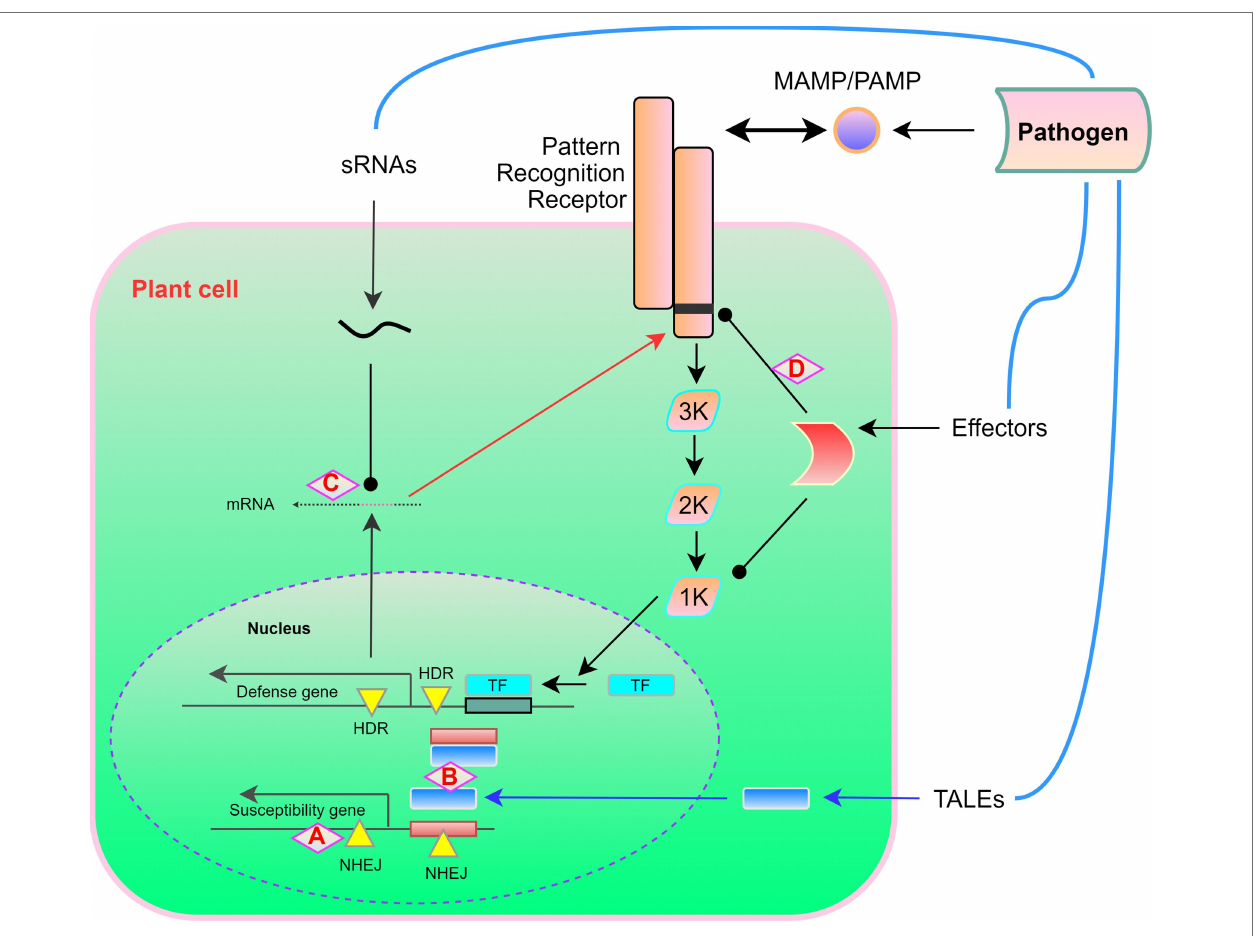
FIGURE 3 | A potential target for applying CRISPR-Cas for engineering of “non-transgenic” disease resistance in plants. In response to pathogen recognition, the plant-induced defense response involves a MAP kinase phosphorylation cascade, which leads to the activation of transcription factors and the expression of defense-related genes. (A) Open reading frame disruption by non-homologous end joining (NHEJ) causes frameshift mutations in susceptibility genes. (B) NHEJ eliminates cis elements to prevent transcription activator-like effector (TALE) activation of susceptibility genes and homology-directed repair (HDR) introduces cis elements, which promotes the TALE-triggered activation of defense genes. (C) Rewriting of transboundary RNAi via HDR-mediated pathogen siRNA targeting. (D) HDR-mediated coding sequence rewriting replaces the effectors produced by pathogens for amino acid residues required for protein recognition, thereby preventing, for example, cleavage or modification. The figures are adopted with modification from those presented by Schenke and Cai